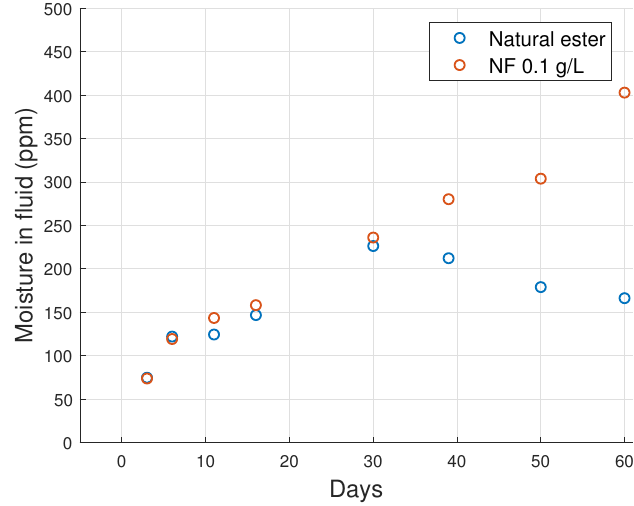
Figure 5. Moisture content in the fluid vs. aging time.